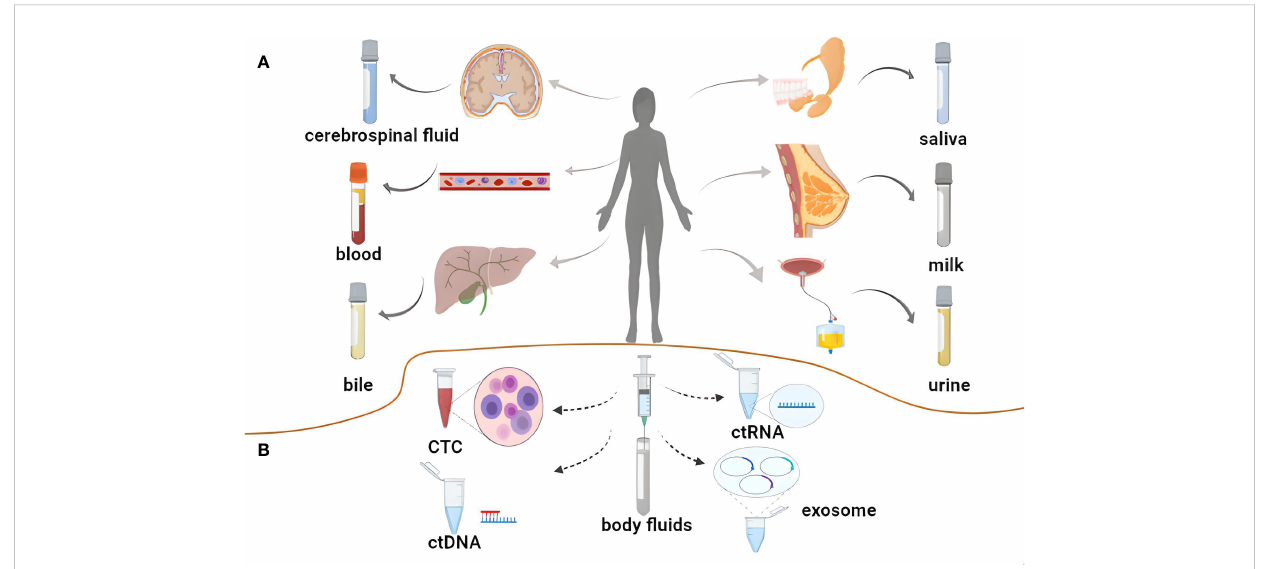
FIGURE 1 Liquid biopsy of tumors. (A) Body fl uids used for liquid biopsy. (B) Novel biomarkers for liquid